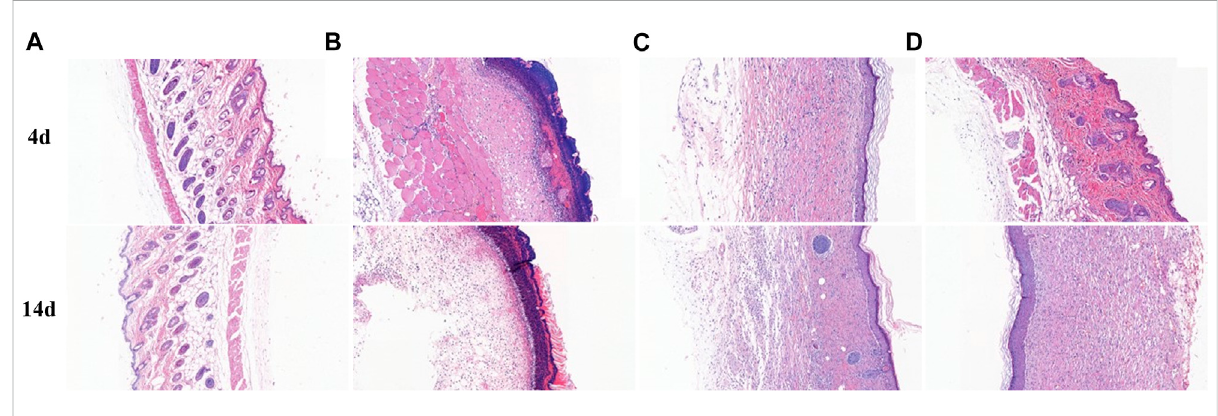
FIGURE 12 H&E staining of healthy and wound skin sections after 4 and 14 days with different